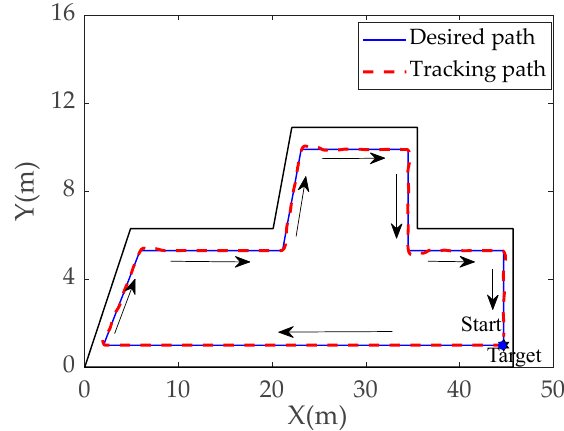
Figure 21. The path tracking in the real man-made river.